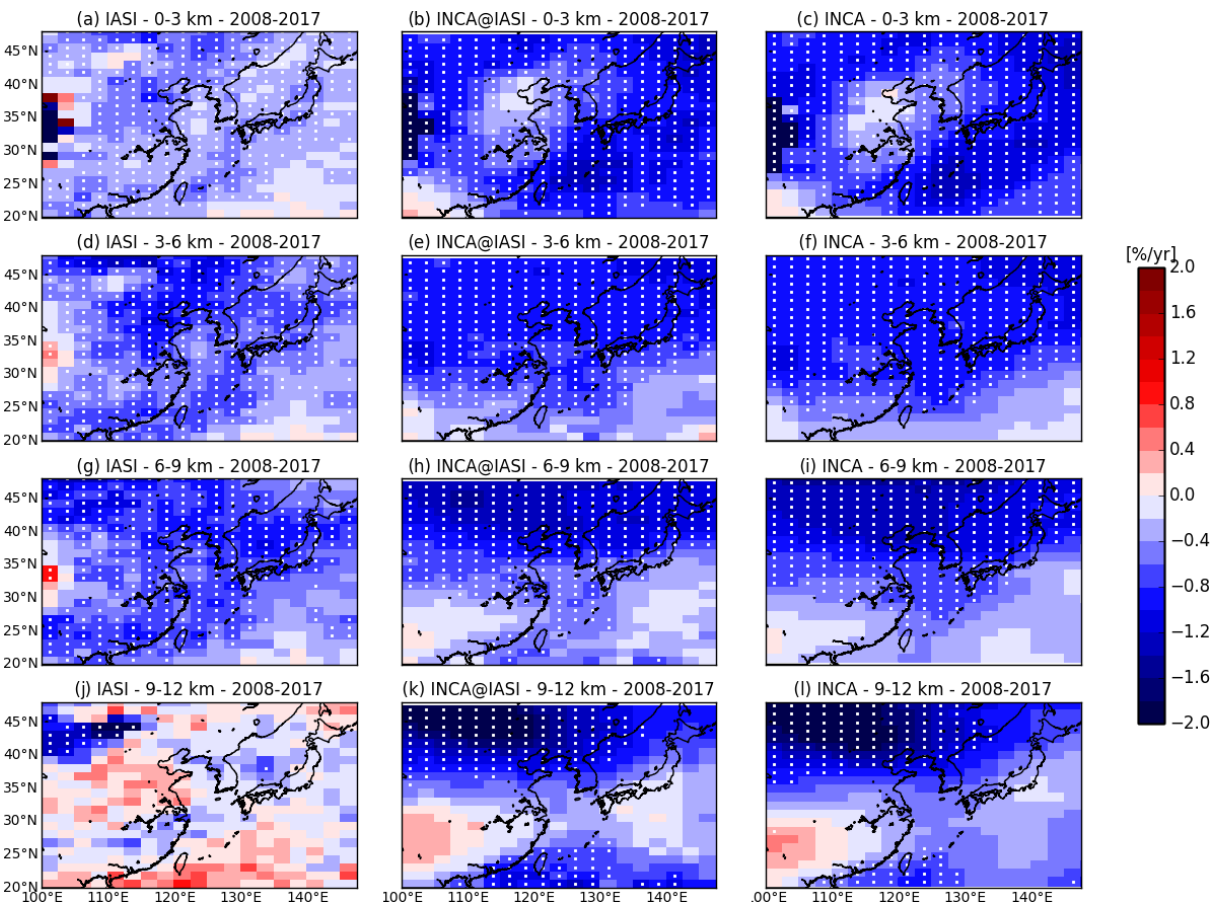
Figure 5. Trends calculated in percent per year at the 2.5 ◦ × 1.25 ◦ resolution for the 0–3, 3–6, 6–9, and 9–12km O 3 partial columns. Panels ( a , e , i , and m ) show the trends derived from IASI, panels ( b , f , j , and n ) show the trends derived from INCA sampled over the IASI pixels, panels ( c , g , k , and o ) show the trends derived from INCA with its native daily resolution, and panels ( d , h , l , and p ) show the trends derived from the INCA reference simulation minus the MET simulation (see the text and Table 4 for details). White crosses are displayed when p values are smaller than